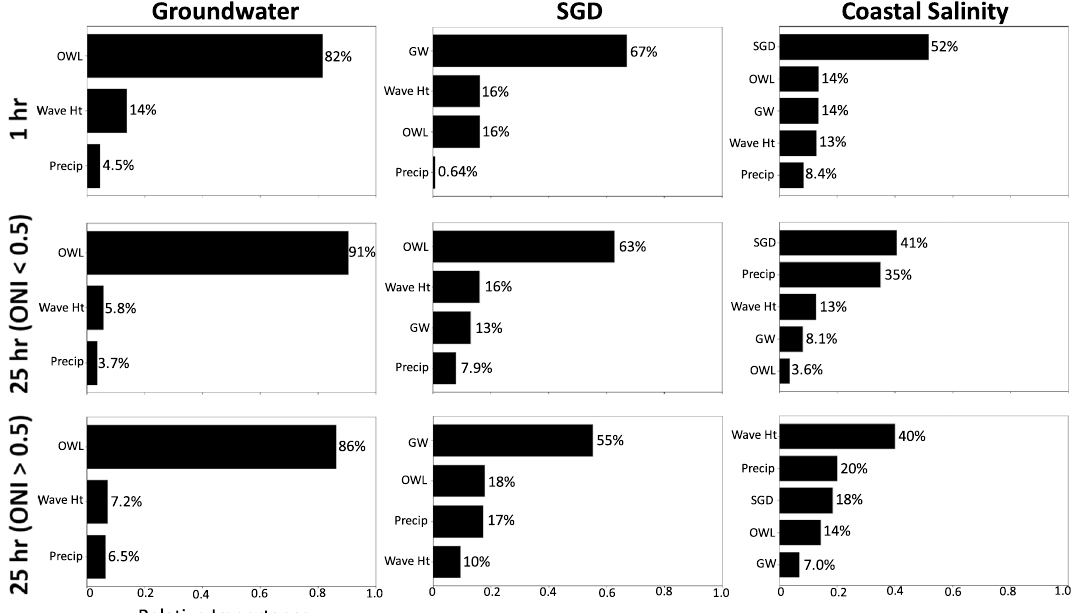
Figure 6. Feature importance calculated using random forest classification conveying relative importance of drivers to groundwater level, SGD, and coastal salinity at 1- and 25-h intervals. 25-h intervals are separated based on periods with El Niño (ONI > 0.5) and without El Niño (ONI < 0.5) conditions